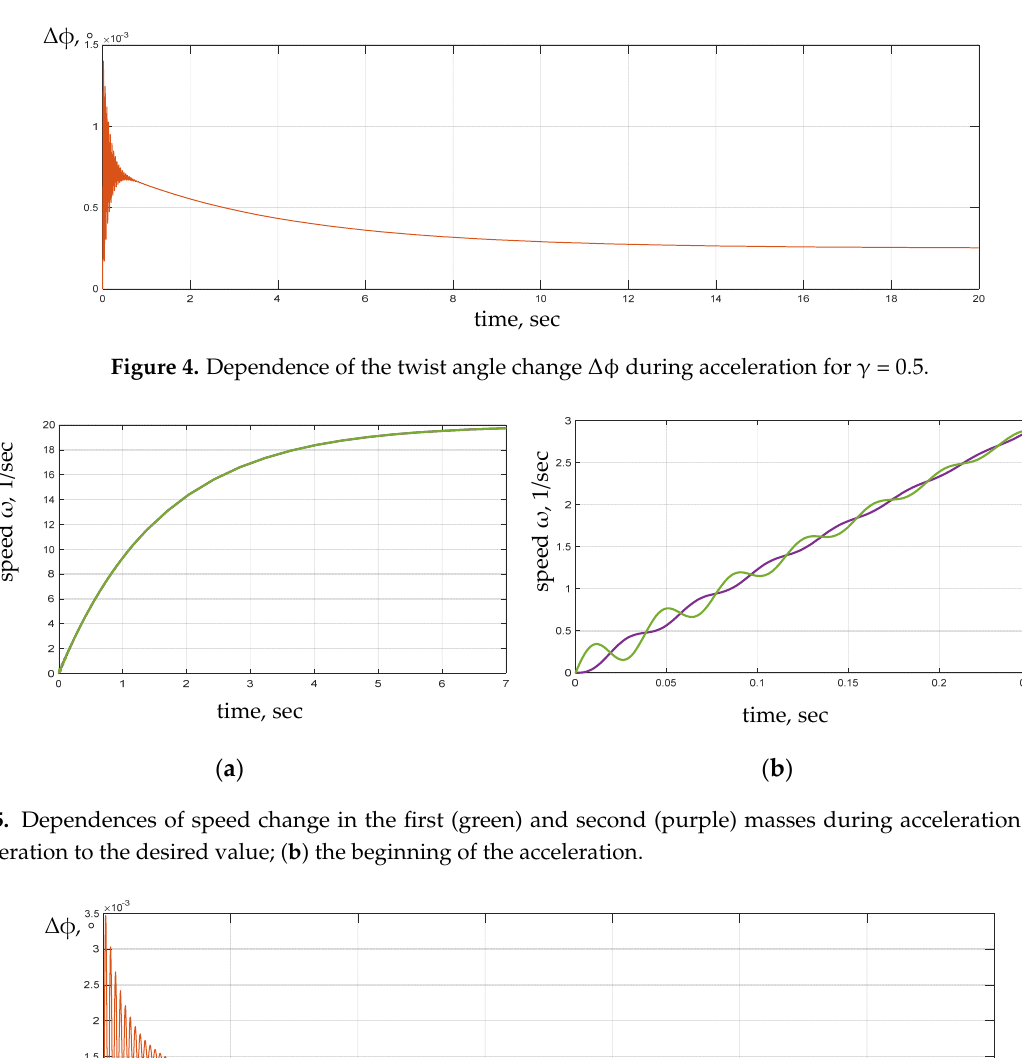
acceleration to the desired value; ( b ) the beginning of the acceleration.